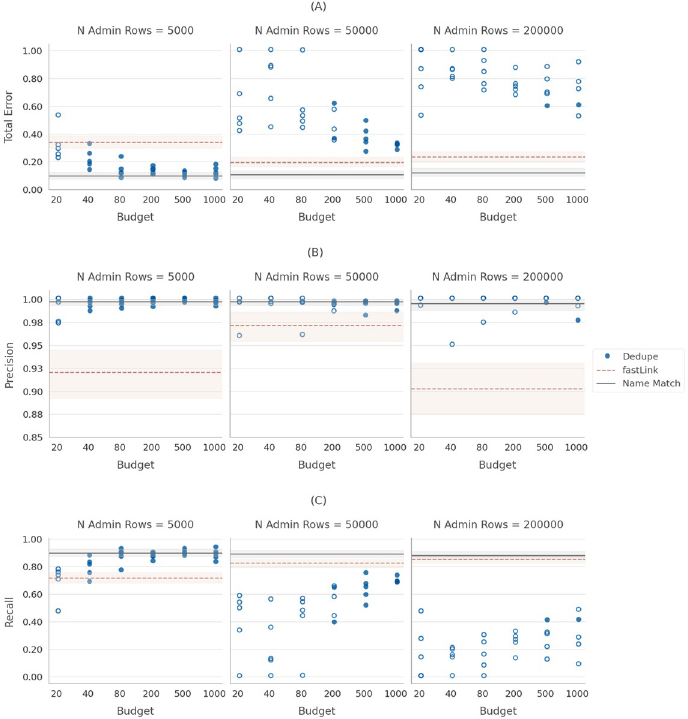
Fig 2. Performance of dedupe, with “off the shelf” setup. A: Total error. B: Precision. C: Recall.